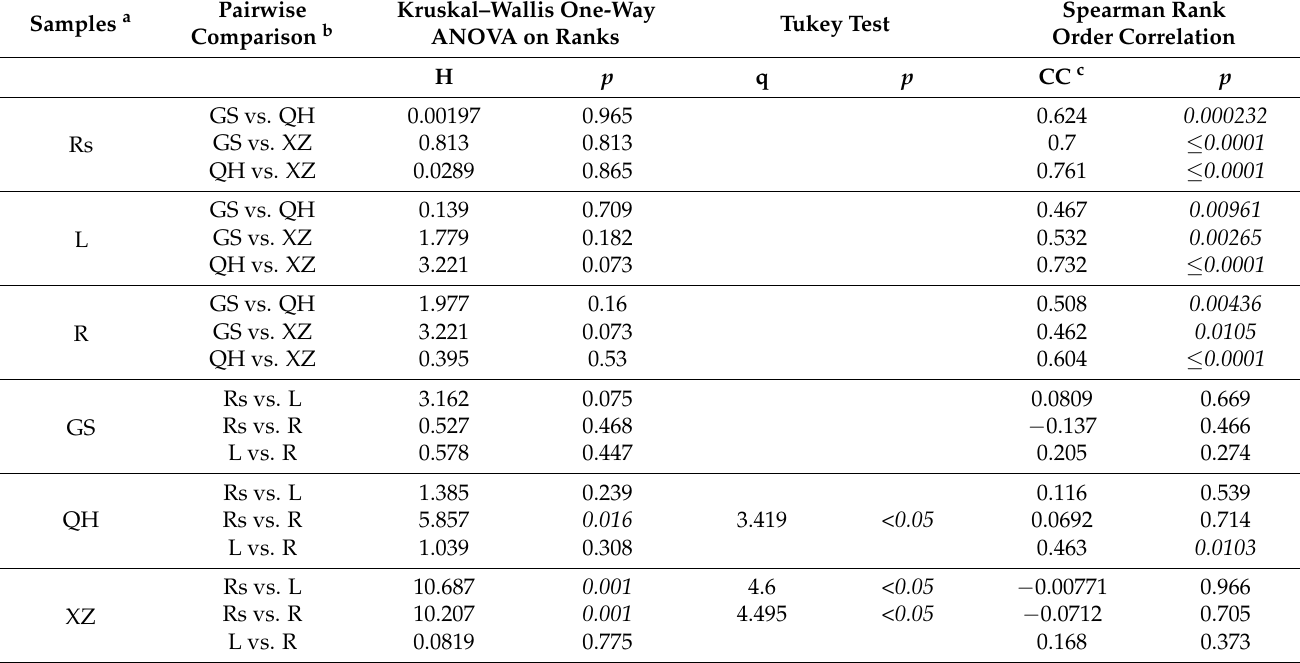
Table 2. p value showing significance of the effects of plant growth elevations and habitats from Kruskal–Wallis one-way ANOVA on ranks (Tukey test) and Spearman rank order correlation for the fungal communities of S. purpurea